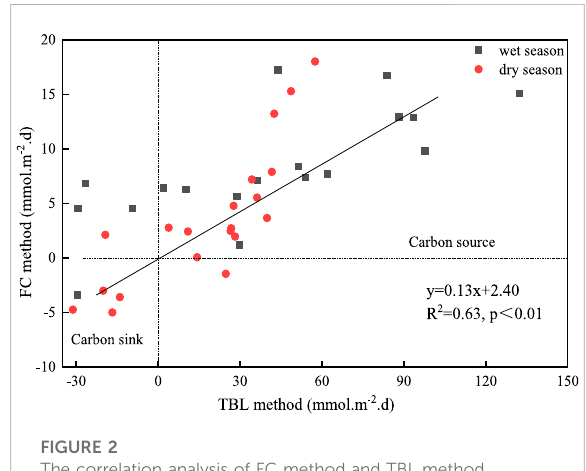
FIGURE 2 The correlation analysis of FC method and TBL